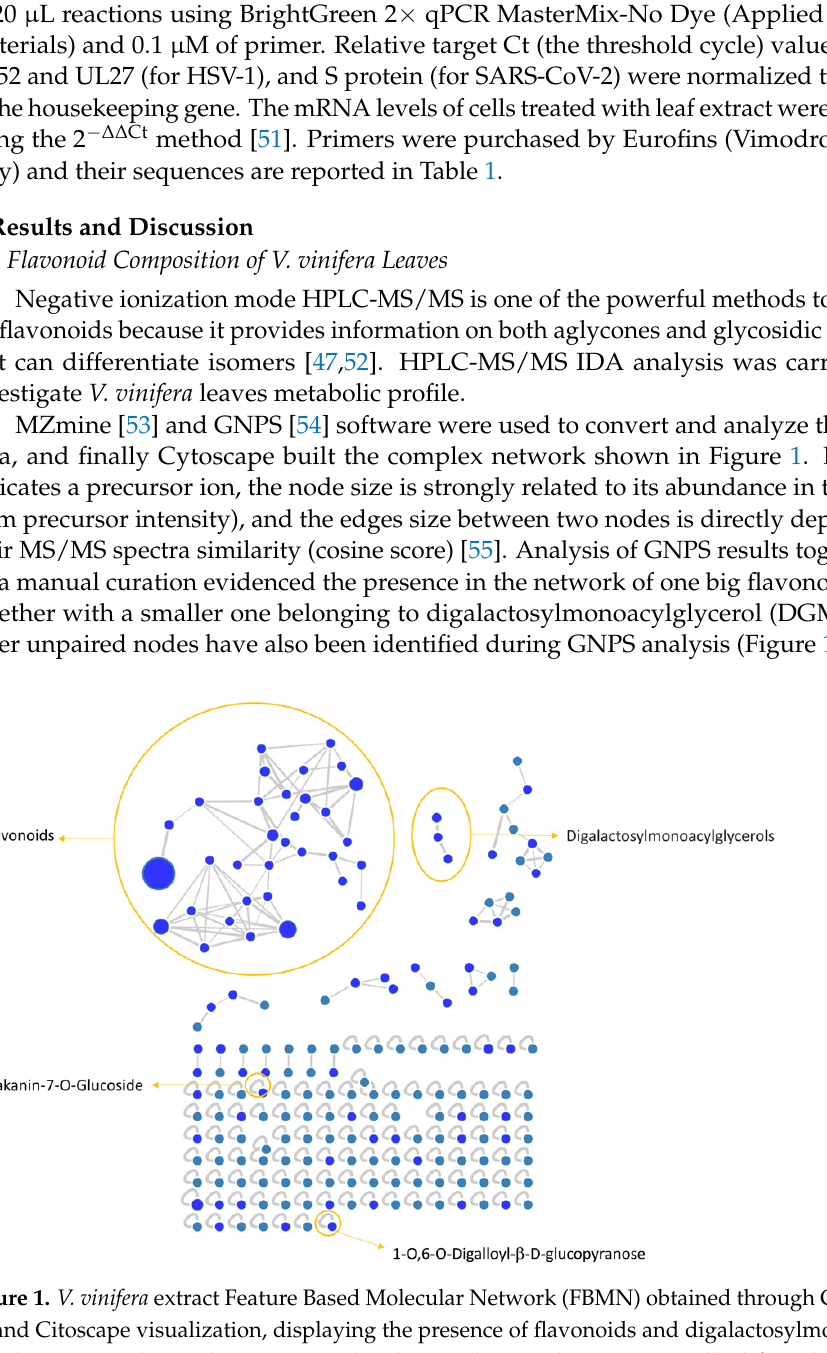
Table 1. Primers used in Real-Time PCR.